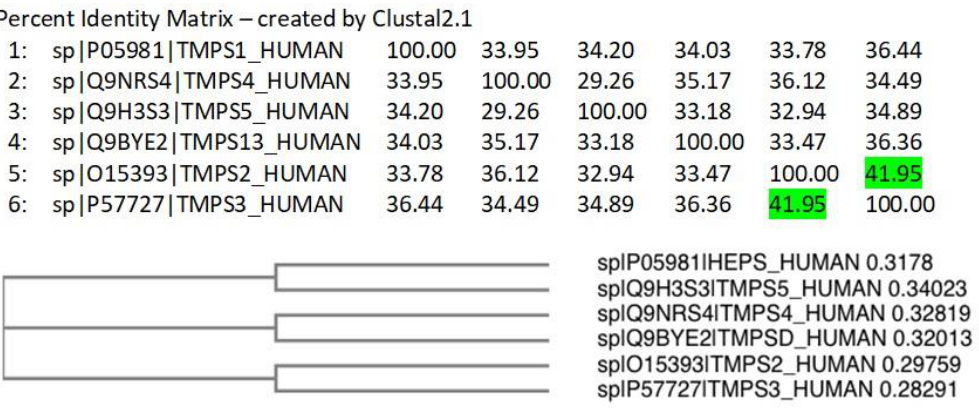
Figure 5. Percent identity matrix and phylogenic cladogram generated from the Clustal alignment of TMPS proteins.